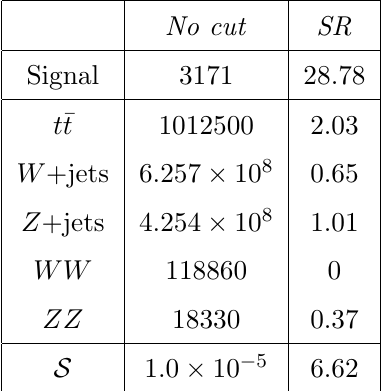
Table 3 . Numbers of signal and background events at the 14-TeV LHC with a total integrated luminosity of 100 fb (cid:0) 1 .